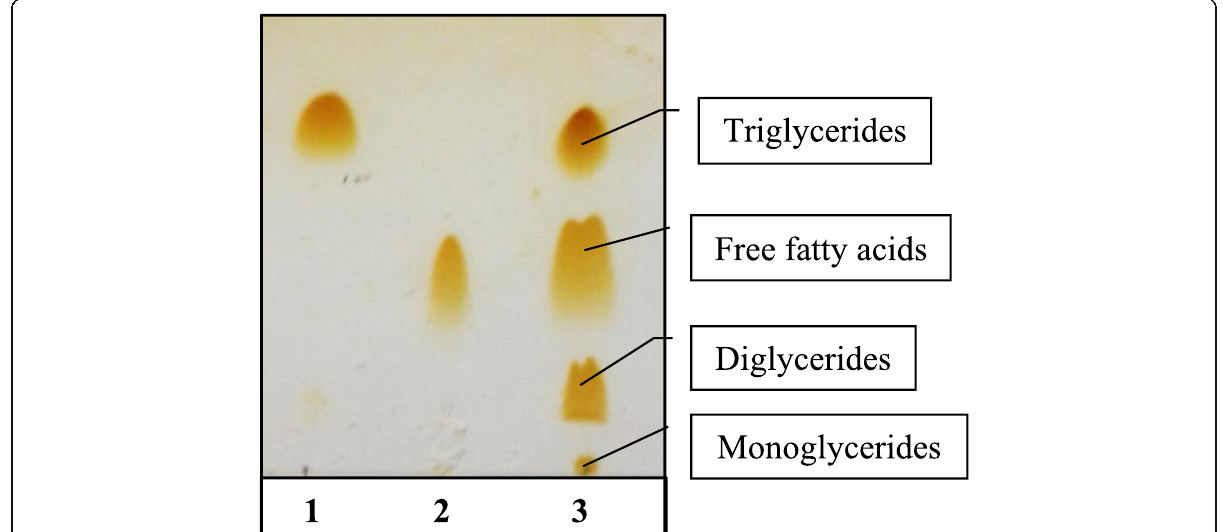
Fig. 1 TLC plate for separation of lipid classes. Lane 1: Triglyceride standard. Lane 2: Oleic acid standard. Lane 3: Hydrolysis products of olive oil by R. oryzae R1